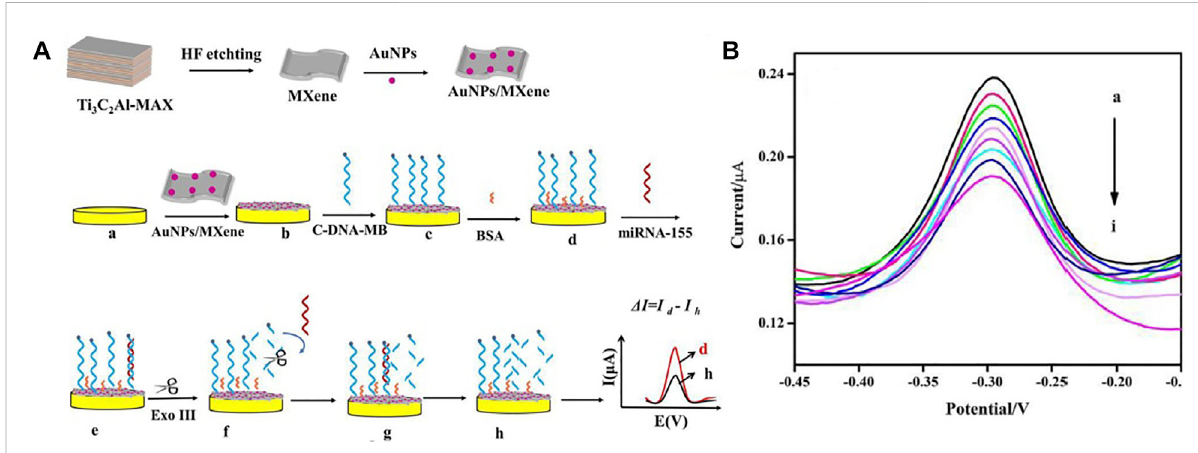
FIGURE 4 (A) Schematic of manufacturing electrochemical biosensor based Au/MXene to diagnosis miRNA-155, (B) diagram of